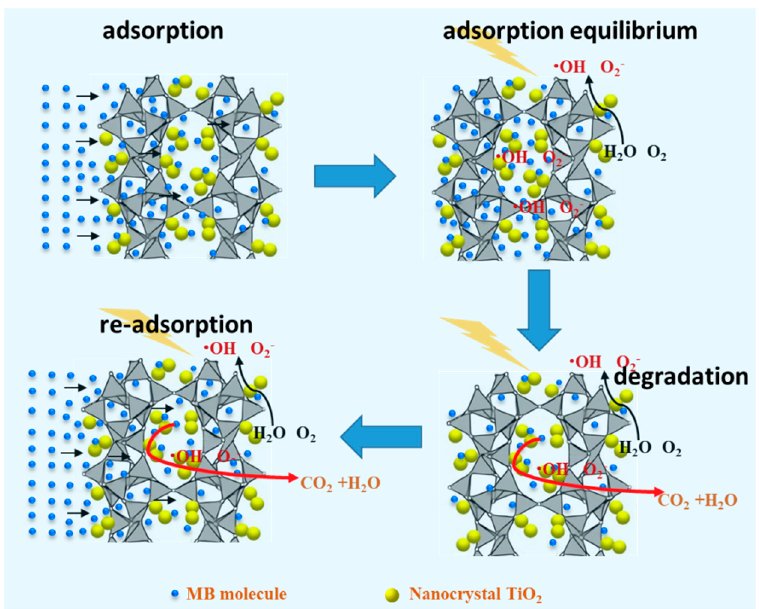
Figure 9. Mechanism of the degradation of MB in aqueous solution.